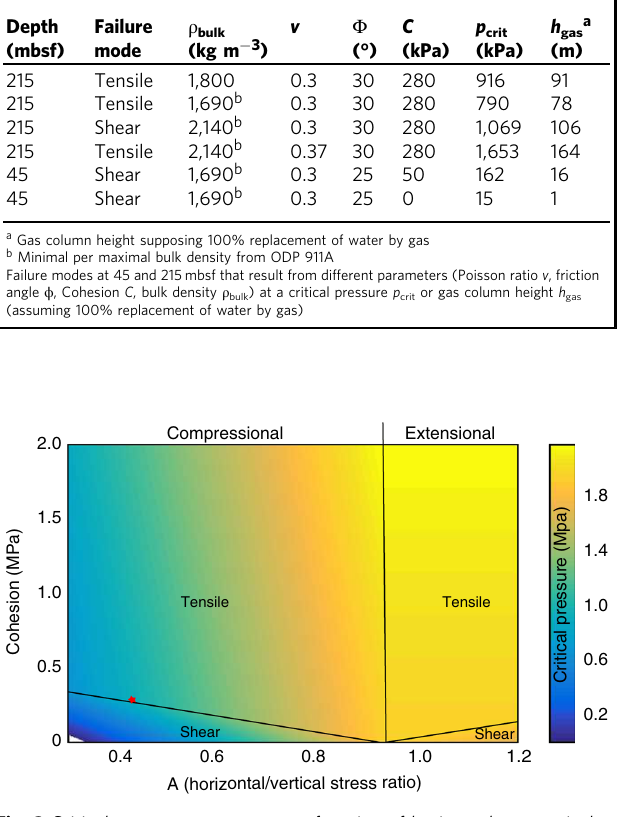
Fig. 3 Critical pore overpressure as a function of horizontal per vertical stress ratio and cohesion at 215 mbsf. The graph shows the critical overpressure (colour coded) under extensional ( σ V < σ H ) or compressional ( σ V > σ H ) conditions that causes tensile or shear failure. The red dot represents critical pore overpressure for tensile failure at the bottom of